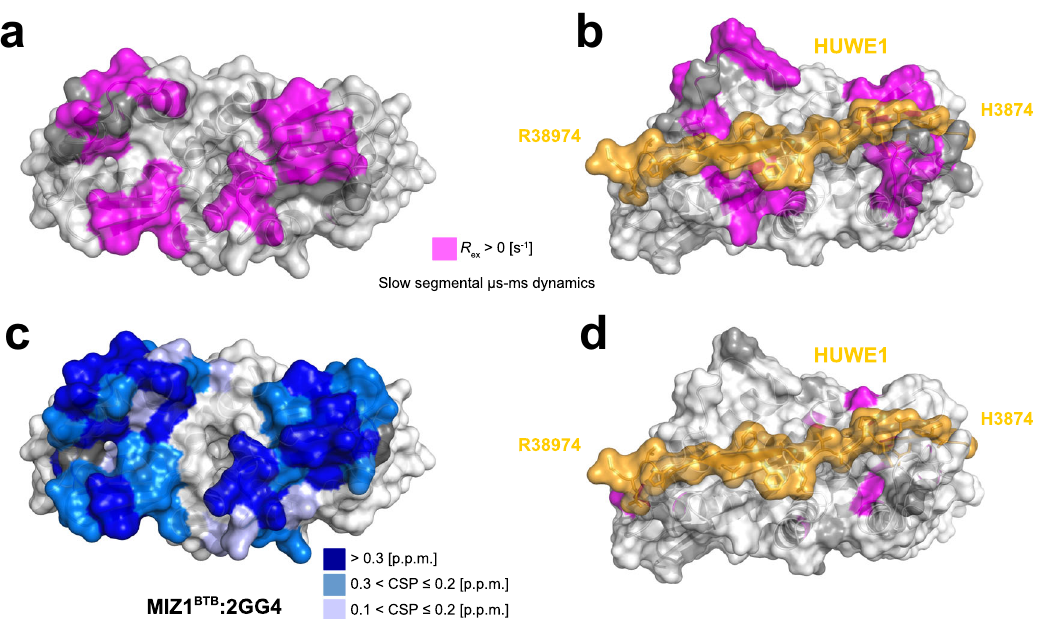
Fig. 5 | Functional dynamics at μ s-ms time scale coincides with the ligand bindingsiteinMIZ1 BTB .a , b Mappingof residuesthatshowslow μ s-mssegmental motions indicated by the chemical exchange R ex (magenta), determined for the MIZ1 BTB , onto the structure of the MIZ1 BTB dimer (PDB id: 2Q81, panel a ) and the structure of MIZ1 BTB with bound HUWE1-derived peptide (PDB id: 7AZX; peptide is